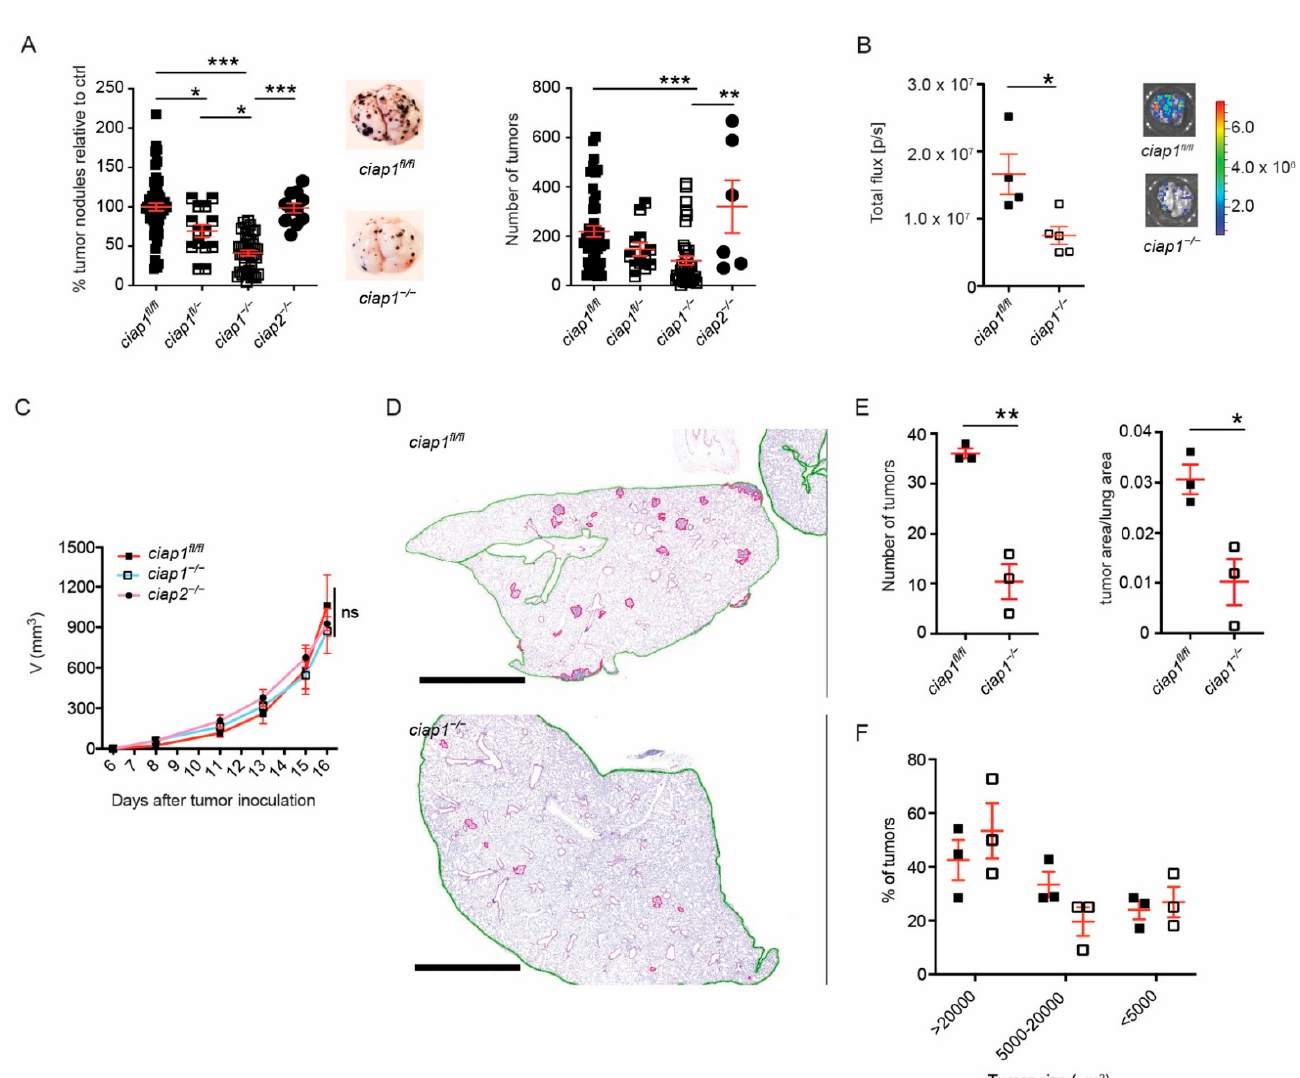
Figure 2 . Loss of cIAP1 causes reduced tumor burden in a metastasis model. ( A ) Percentage of superficial B16-F10 tumor nodules in ciap1 fl/fl , ciap1 fl/- , ciap1 − / − or ciap2 − / − lungs normalized to the average number of tumor nodules identified in the Wt ( ciap1 fl/fl ) control. Tumor cells were injected i.v. and nodules formed in the lung were counted 13 days